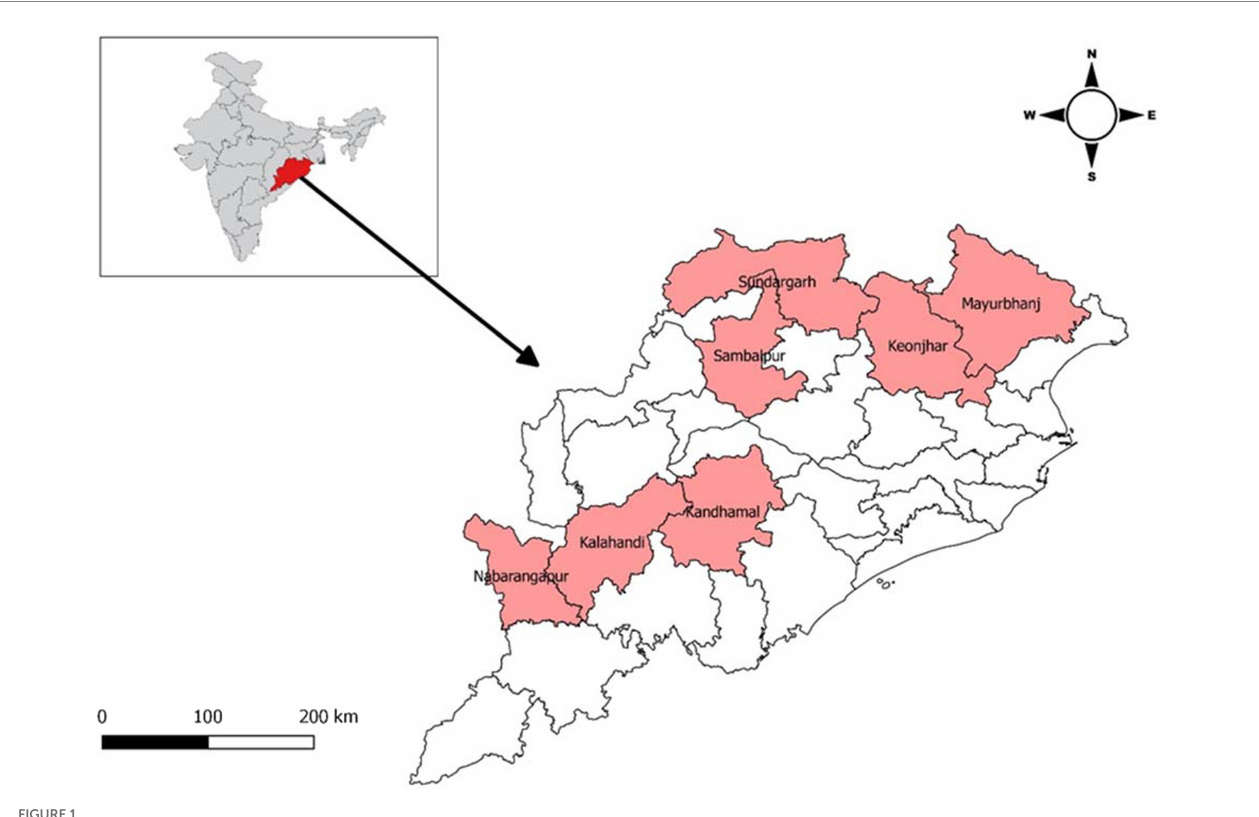
FIGURE 1 Heat map of the districts included in the